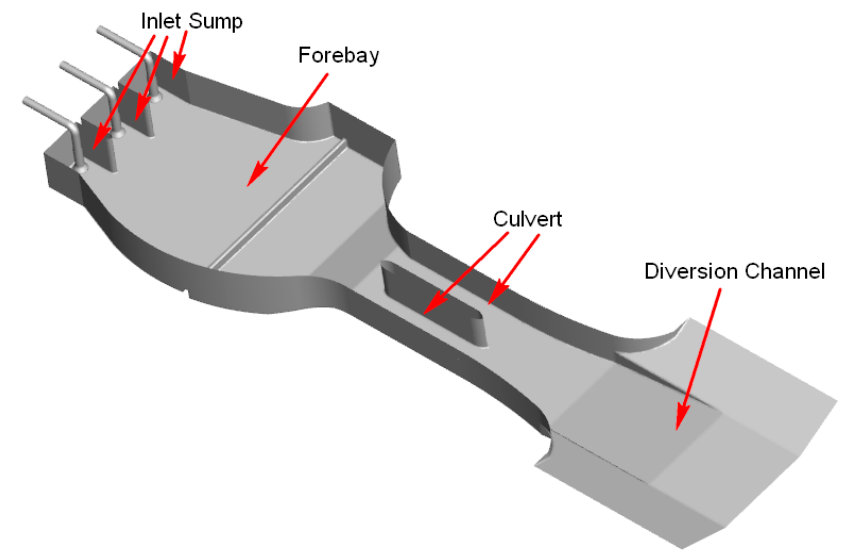
Figure 1. The computing domain.